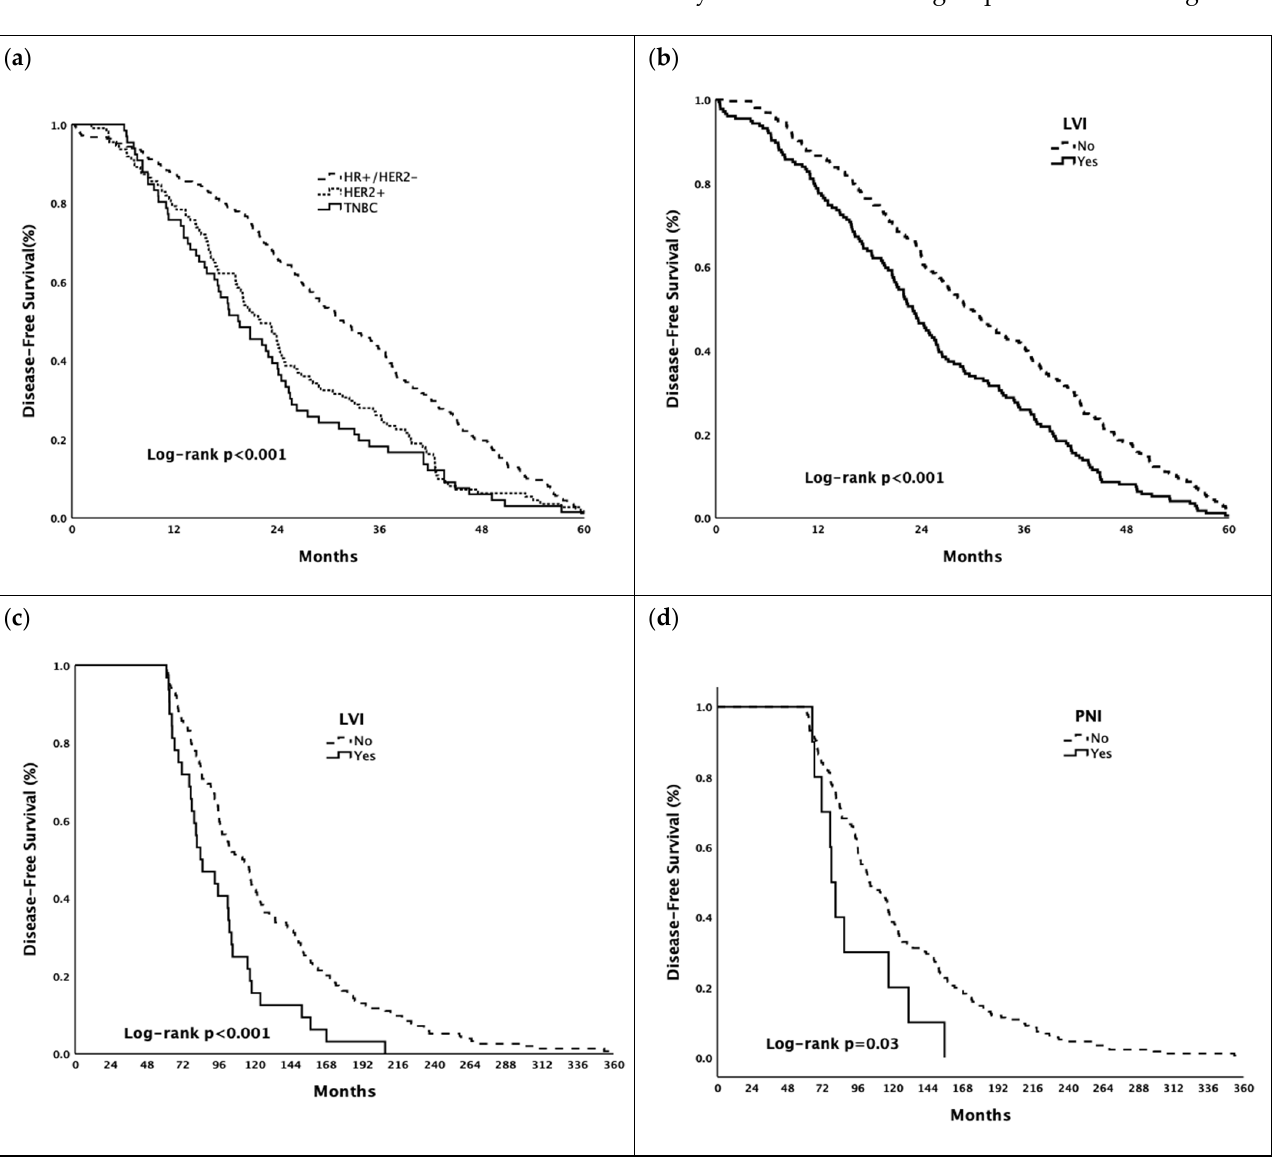
Figure 1. Kaplan–Meier estimates of disease-free survival (( a , b ) in early recurrence group, ( c , d ) in late recurrence group). Abbreviations: HR—Hormone Receptor; HER2—Human Epidermal Growth Factor Receptor 2; LVI—Lymphovascular Invasion; PNI—Perineural Invasion; TNBC—Triple-Negative Breast Cancer.